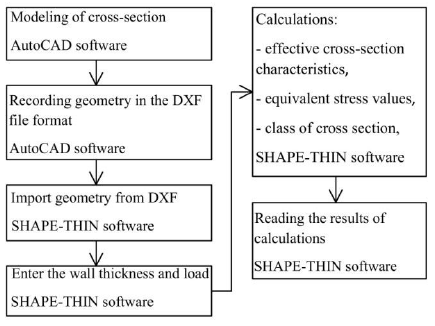
Figure 2: Flow chart: Calculation of effective section properties using AutoCad and SHAPE-THIN software